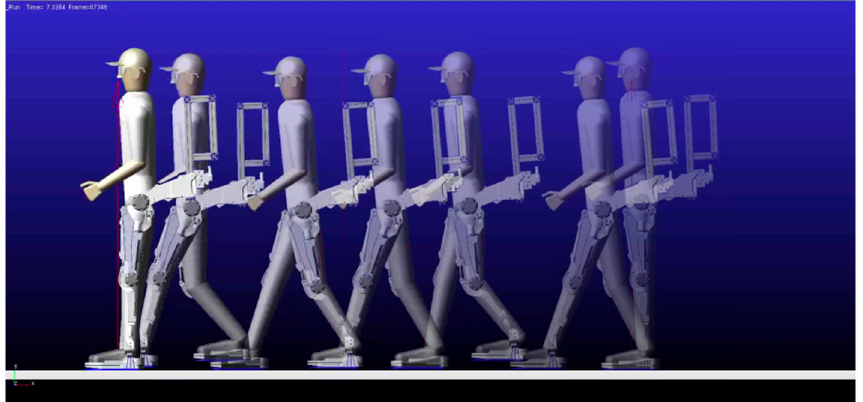
Figure 24. ADAMS simulation of man–machine coupling system.